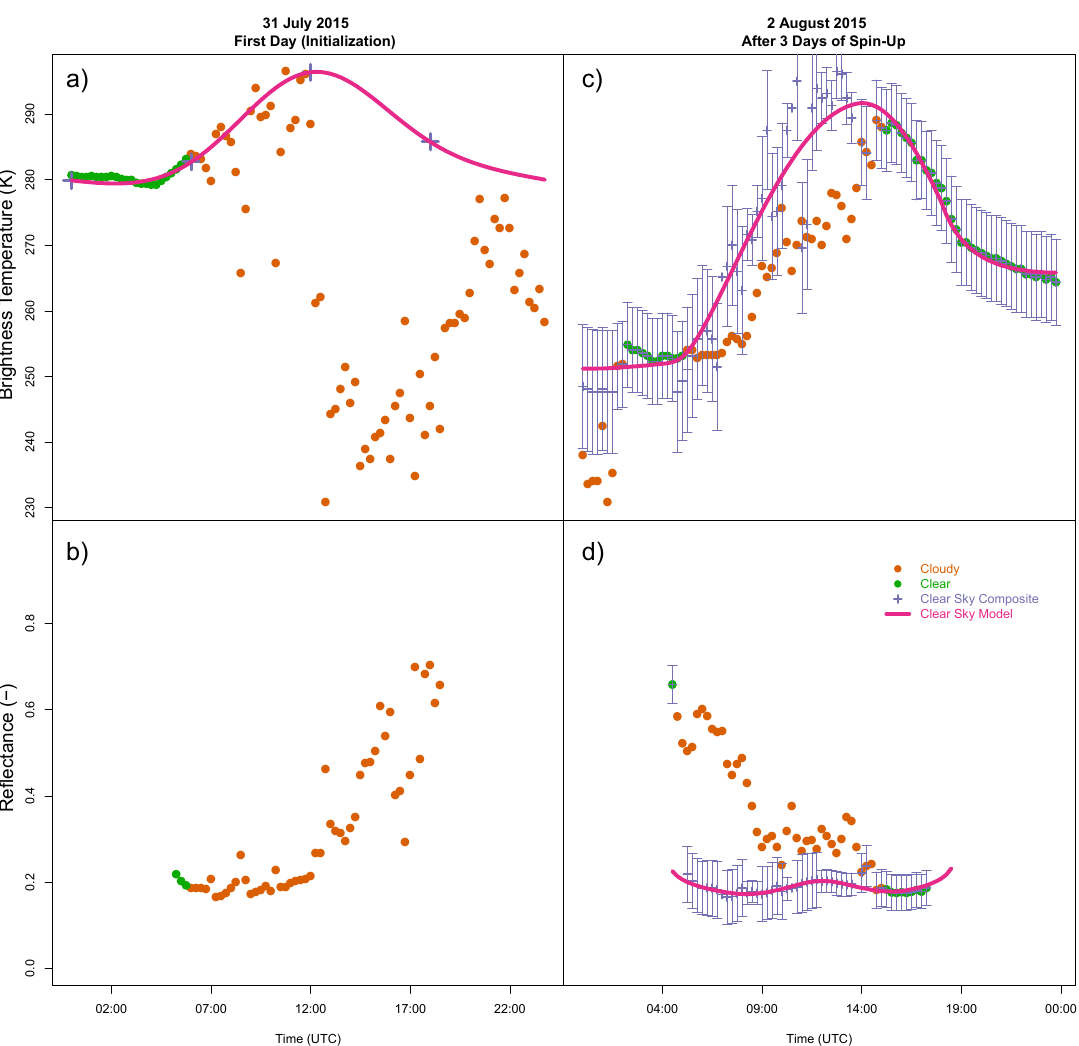
Figure 5. Estimation of the clear-sky reflectance and brightness temperature diurnal cycle by use of parametric models. On the first day of processing, four NWP-based skin temperature predictions ( a , large blue crosses) were used to estimate a continuous diurnal cycle of brightness temperature ( a , pink curve). This is the reference for the first clear/cloudy separation (clear = filled green circles; cloudy = filled orange circles). Clear-sky reflectance is not yet available on the first day ( b ). After 3 days, enough clear-sky observations (blue crosses and error bars) of brightness temperature ( c ) and reflectance ( d ) had been collected. This allows a high quality parametric estimation of both clear-sky brightness temperature and reflectance diurnal cycles (pink curves), which are the foundation for subsequent cloud